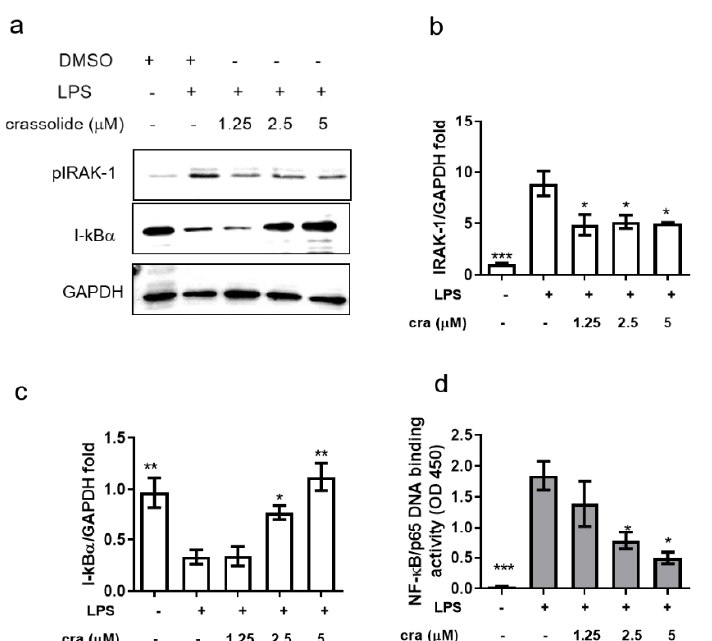
Figure 6. Effects of crassolide on the pIRAK-1 and IkB α expression and p65 nuclear translocation in BMDC stimulated with LPS. BMDCs were treated for 2 h with either various doses of crassolide or 0.1% DMSO, followed by LPS stimulation (100 ng/mL) for 6 h. ( a ) Cells were harvested and total protein was extracted for Western blotting assay to detect pIRAK-1, and IkB protein levels. ( b , c ) GAPDH was used as a loading control, and the quantified expression levels by ImageJ software were plotted in the bar graphs. ( d ) NF-κB p65 DNA-binding activity in nuclear extracts of BMDC cells was determined using the TransAM kit, with the optical density at 450 nm (OD450). Data are presented as mean ± SEM of triplicate samples from one of three independent experiments. * p < 0.01, ** p < 0.01, *** p < 0.001, versus LPS + 0.1% DMSO-treated group, tested by one way ANOVA followed by Tukey’s multiple comparison test.